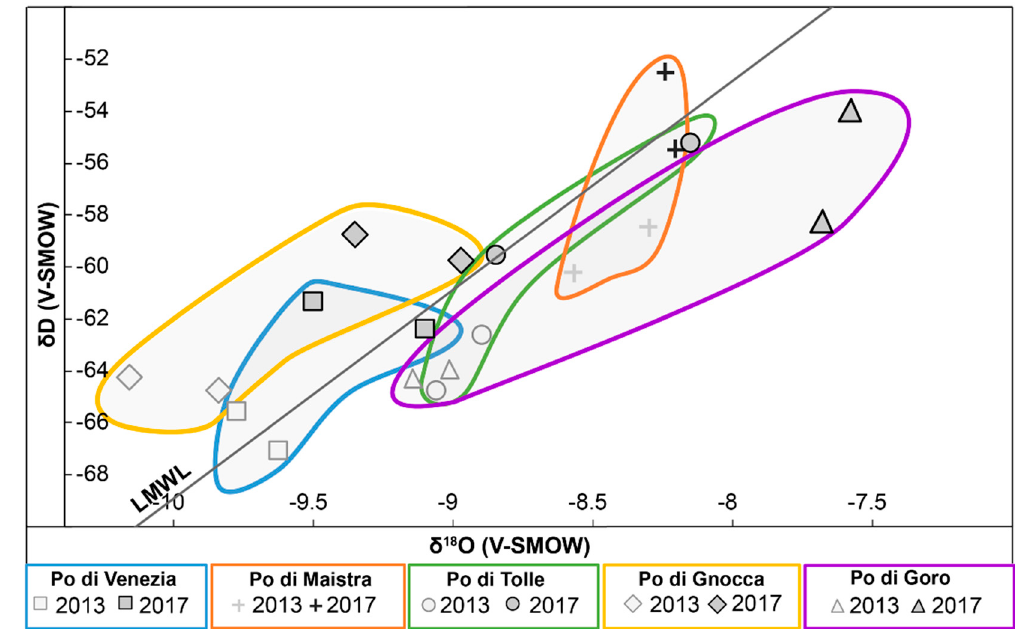
Figure 4. The δ D vs. δ 18 O of Po river water collected during summer 2017 in the deltaic sector of Po river (data from Table 3). Note that the diagram does not include the water samples collected in the deltaic mouths (see Figure 2 and Table 3). Data relative to the summer 2013 on samples collected exactly in the same sites ([17]; see Supplementary Table S3 in the Supplementary Materials) are also reported for comparison.